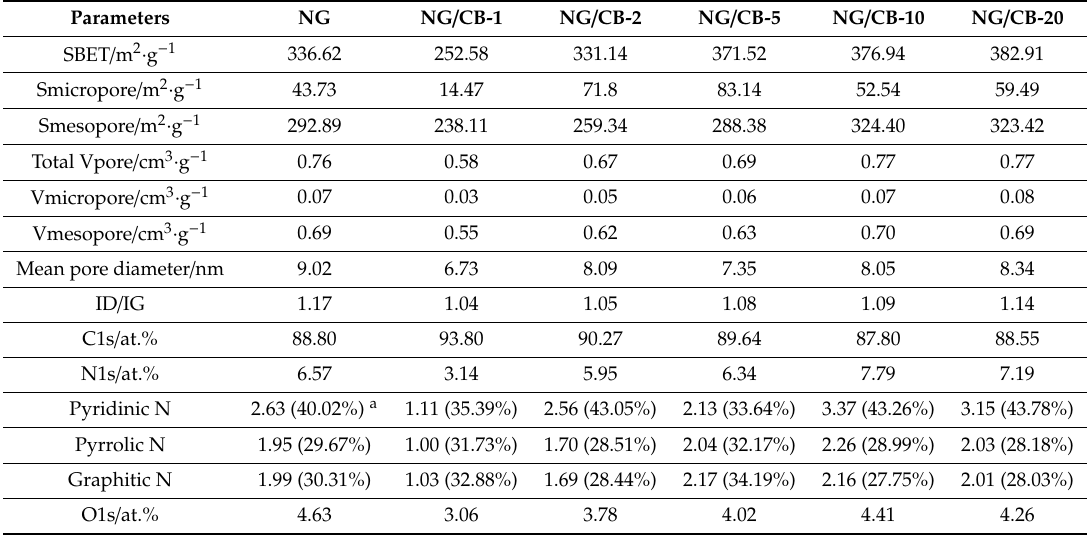
Table 2. Characteristics and textural parameters of NG / CB-x